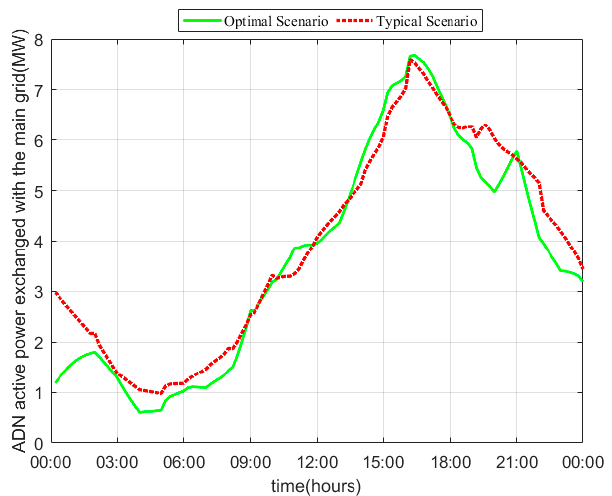
Figure 19. The total ADN’s active power in both the optimal and typical operation.